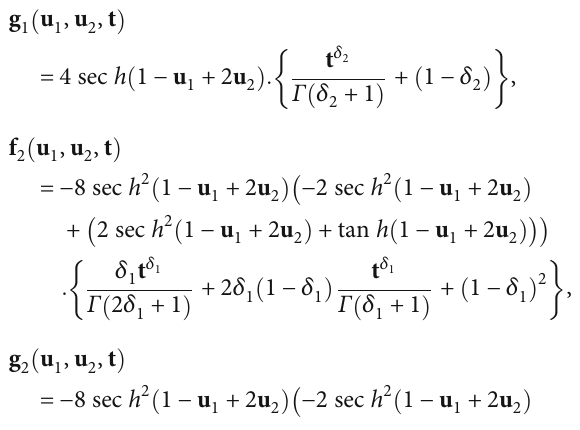
u t Þ . (b) 2D view of multiple fractional orders via JTDM of Example 16 for f ð u 1 , 2 ,